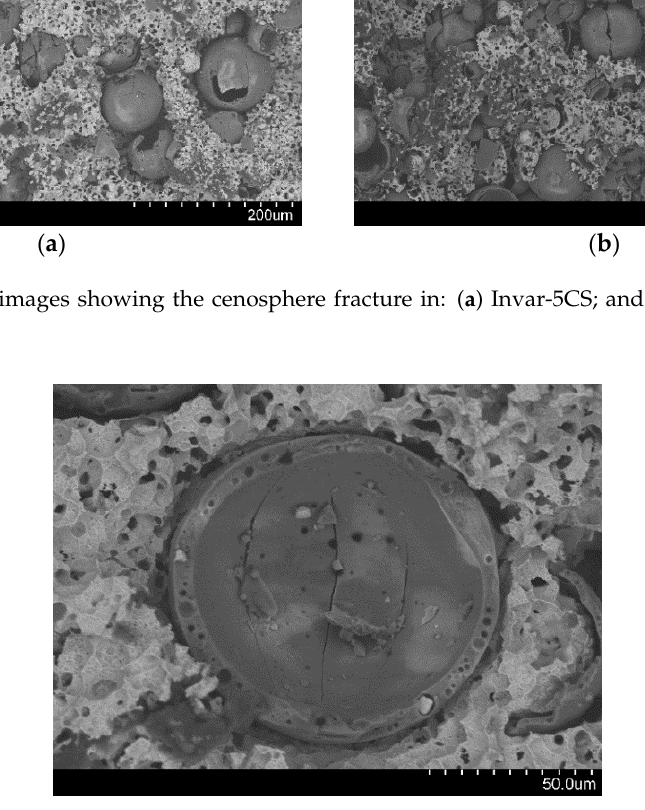
Figure 11. The pattern of crack development on cenospheres under quasi ‐ static loading in the top ‐ bottom direction.